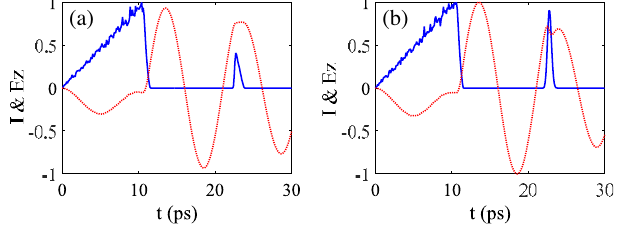
FIG. 11. Current profile (blue) and corresponding wakefield (red). (a) and (b) used the same drive bunch, but the main bunch ’ s profiles are different: (a) reverse triangle and (b)